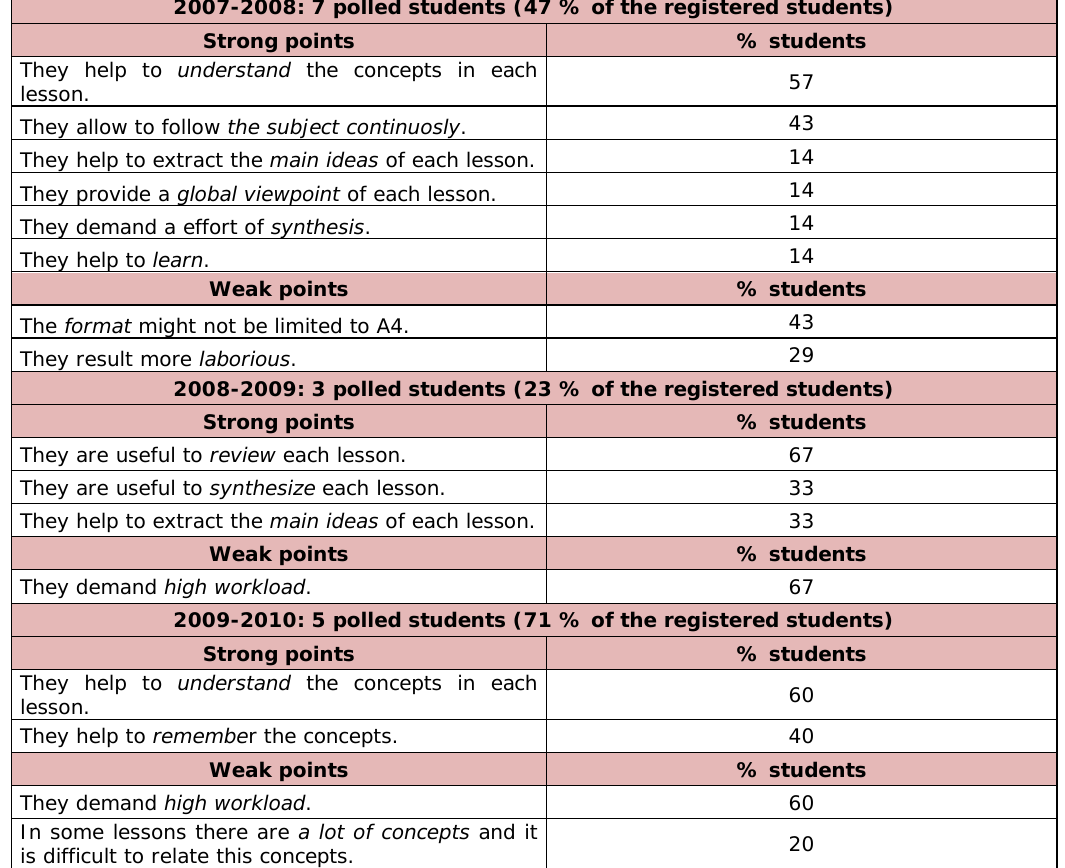
Table 3. “Results of the opinion poll about the strong points and weak points in the concept maps in the subject Analytical Techniques of the Environment”.